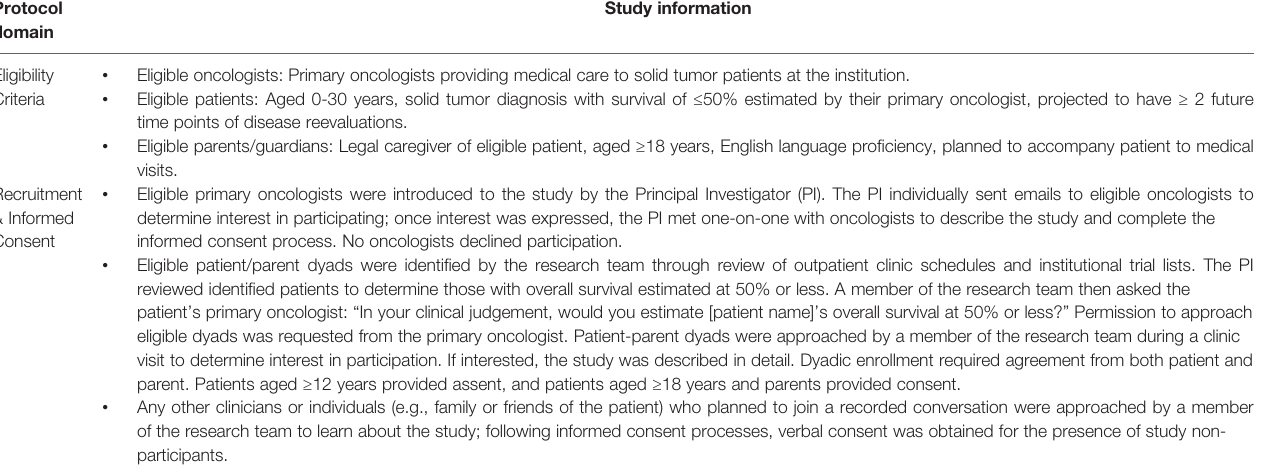
TABLE 1 | Eligibility criteria, recruitment, and informed consent